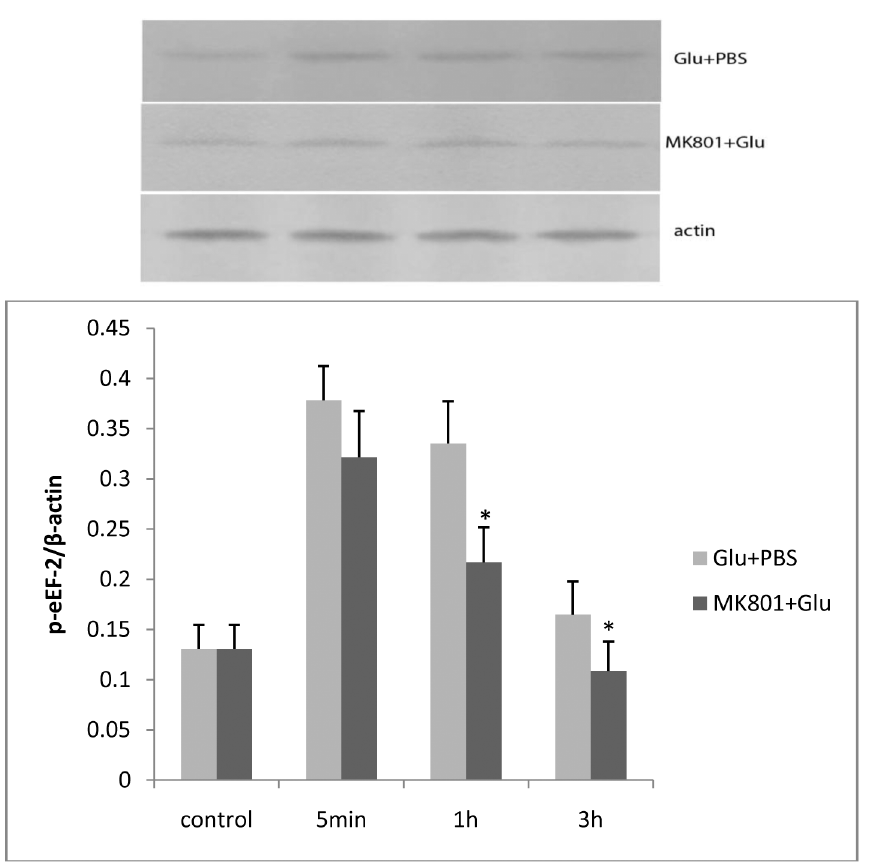
Fig 8. After L-glutamate stimulation, increased expression of phospho-eEF-2 was detected in the Glu + PBS group at 5 min, 1 h, and 3 h. The increase of phospho-eEF-2 expression was attenuated by MK-801. The asterisk represents P <